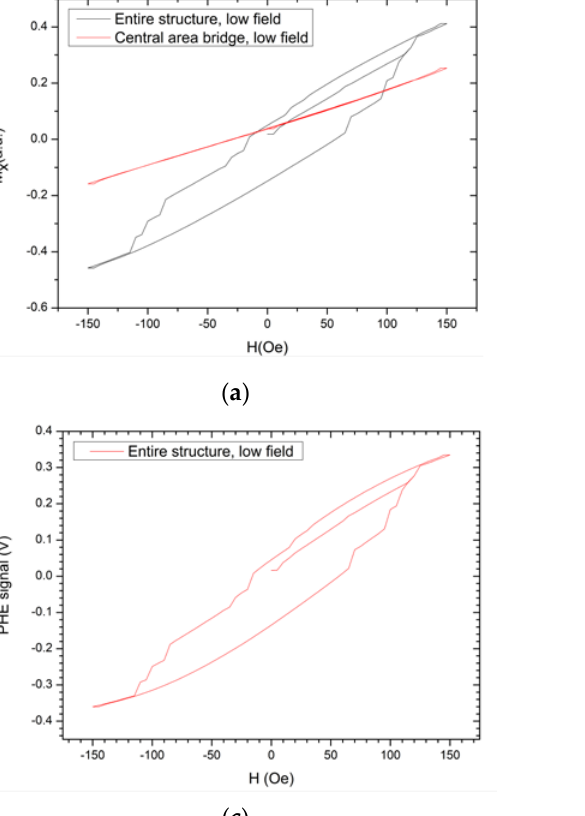
Figure 8. AMR bridge sensor, multi-domain simulation results for low field values: ( a ) Magnetization distribution along the x -axis; ( b ) Magnetization distribution along the y -axis; ( c ) PHE signal for the entire structure; ( d ) PHE signal for the central area of the structure (bridge).